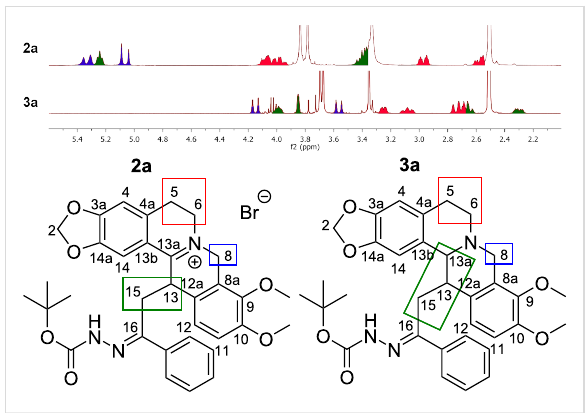
atom are significantly shifted downfield (assigned by 2D-NMR analysis, see Supporting Information File 1). For example, the two doublets at 5.06 and 5.36 ppm, assigned to the C8 protons of DHBER 2a , are shifted to 3.55 and 4.15 ppm, respectively in THBER 3a (signals highlighted in blue, Figure 3). Similar considerations can be extended to protons bound to C5, C6, (signals highlighted in red, Figure 3), and to protons of 13a-C, 13-C and 15-C (signals highlighted in green, Figure 3).